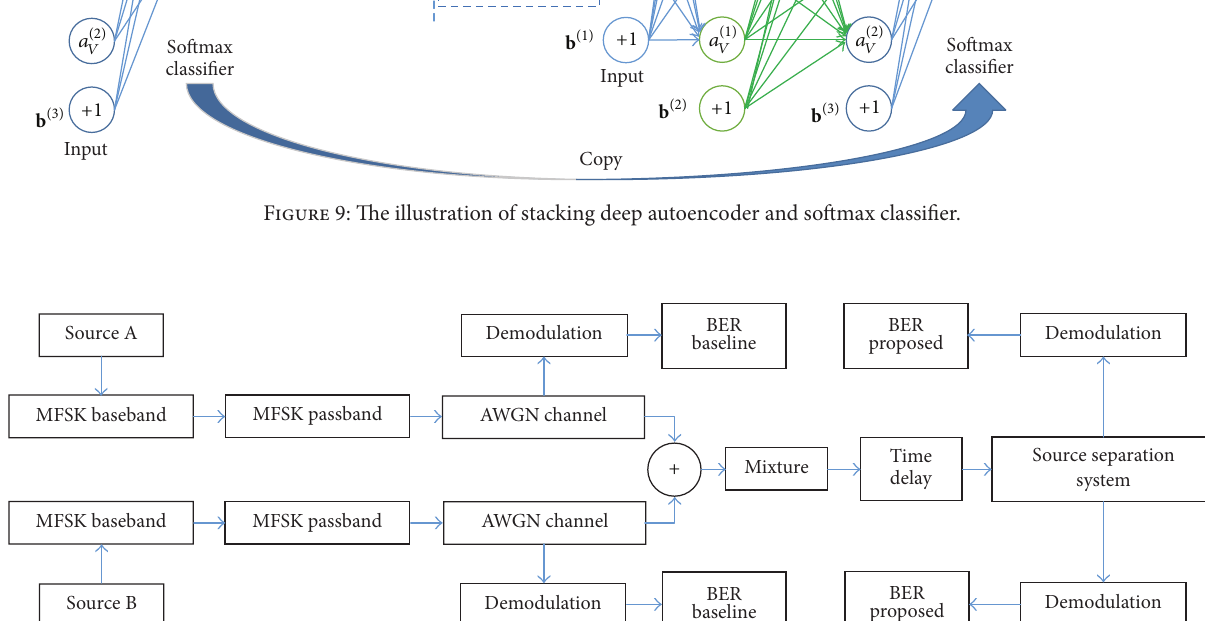
Figure 10: The simulation system used in the